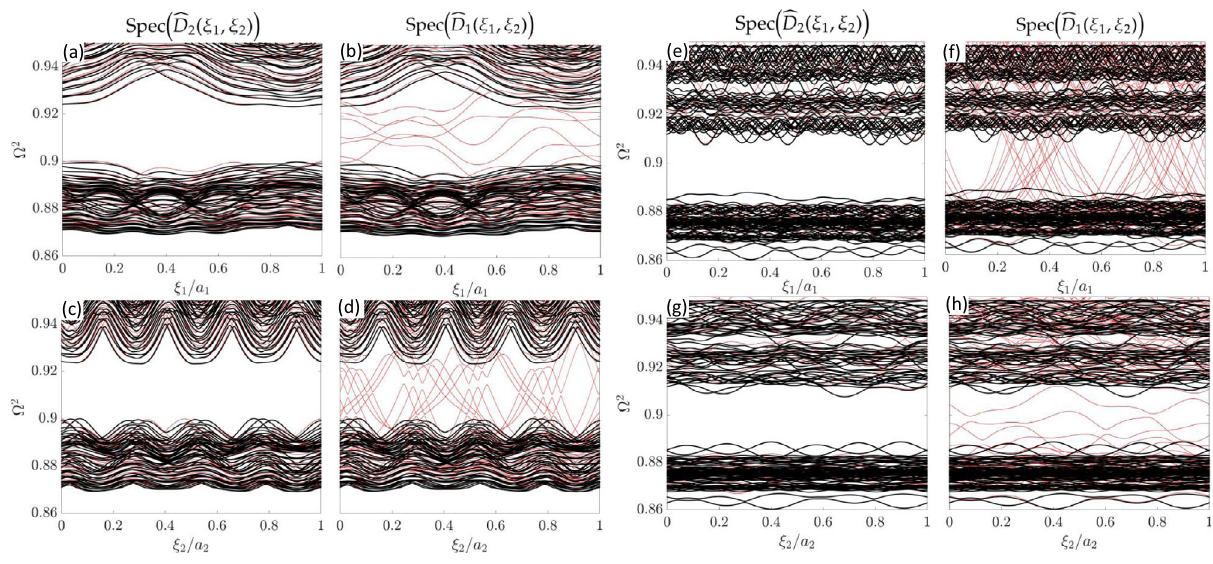
Fig. 7 Observation of edge states and bulk-boundary correspondence for lattice with β ¼ π = normalized phason coordinates ξ 1 / a 1 , ξ 2 / a 2 for 100 × 100 lattice with periodic boundary conditions (black curves), or smaller lattices (red curves) with periodic-open ( b D 2 ð ξ 1 ; ξ 2 Þ ) and open-periodic ( b D 1 ð ξ 1 ; ξ 2 Þ ) boundaries along the a 1 and a 2 directions. In particular, ( a – d ) focus on the orange gap (V) using a